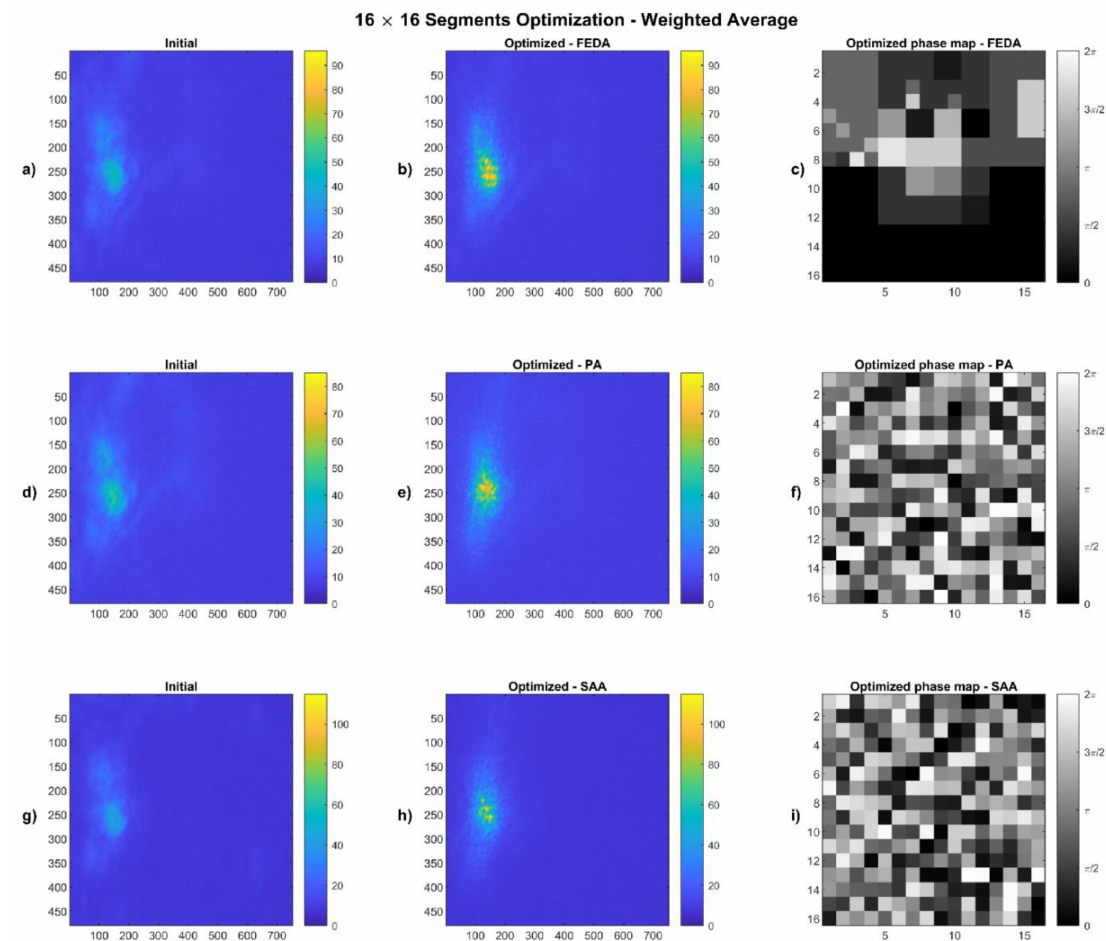
Figure 9. Results for the 16 × 16 segmentation of the phase map with the weighted average being the cost function. ( a , b ), ( d , e ), ( g , h ) stand for the initial and optimized intensity distributions captured by the CMOS when running FEDA, PA, and SAA algorithms, respectively. All initial’s intensity distributions were captured before running each algorithm and after setting the phase of the incident beam to zero. For the intensity distributions, the grid values correspond to pixel units of the CMOS and the colorbar/intensity range can have values in between 0–255. ( c , f , i ) are the achieved optimal phase maps/matrices projected in the SLM after running FEDA, PA, and SAA, respectively. For the phase maps, its values range from 0 (black) to 2 π (white) with 10 values in between this